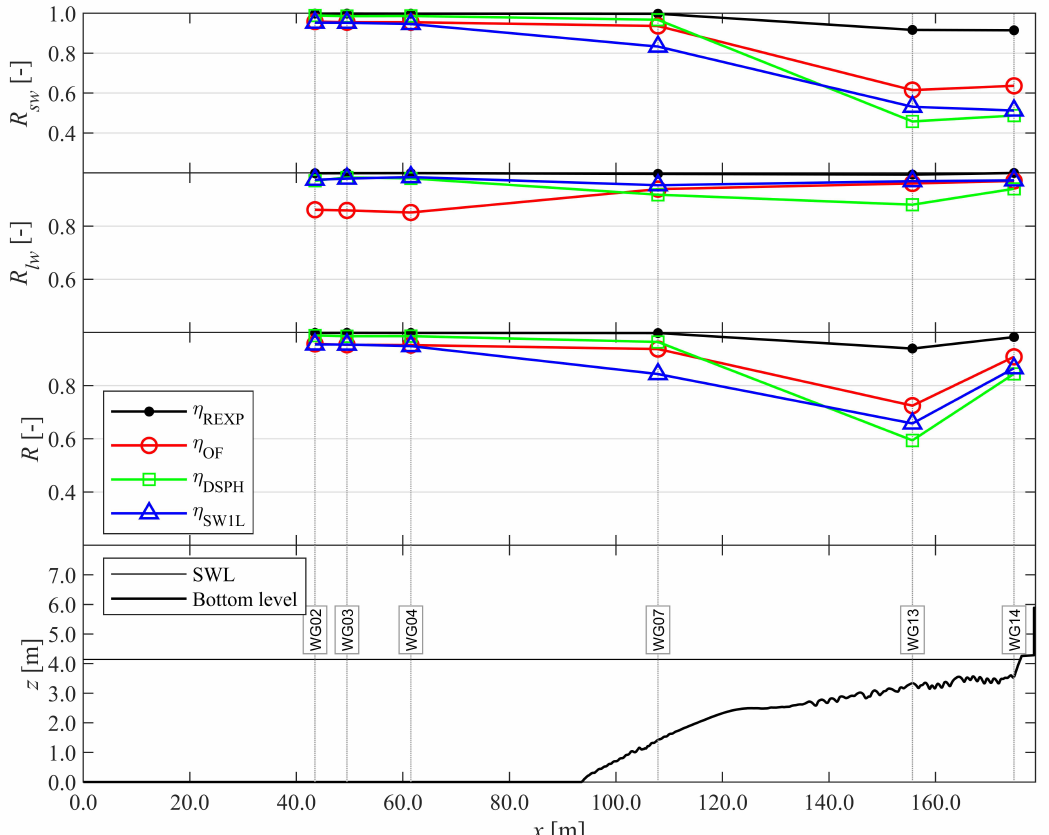
Figure 11. Comparison of R evaluated for η (of REXP, OF, DSPH and SW1L with reference to EXP) up to the dike toe. From top to bottom: R sw for η SW , R lw for η LW , R for η , and finally an overview of the sensor locations, SWL, and bottom profile. Adapted from the work in [3], with permission from the authors,